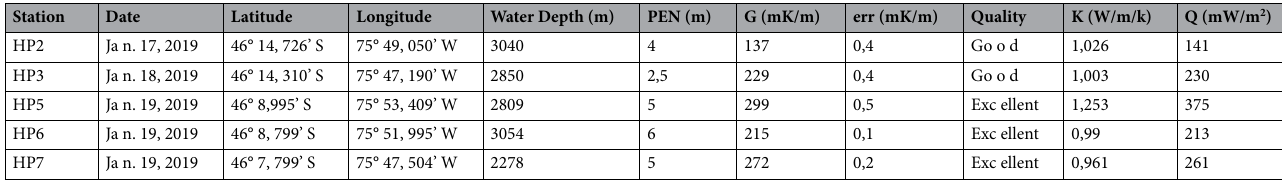
Table 1. Heat flow sites in the vicinity of the Chile Triple Junction (MR18-06 cruise report; 75 ).